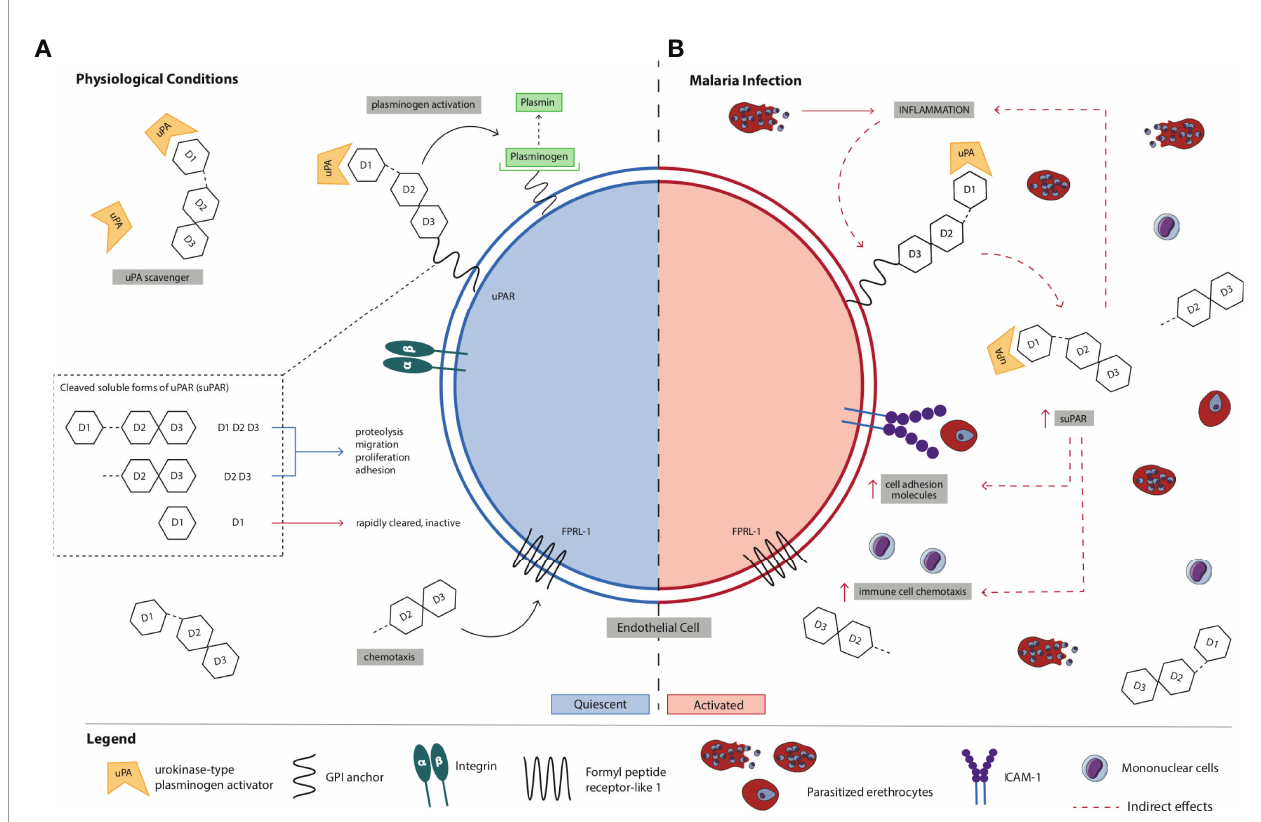
FIGURE 1 | Schematic representation of the (A) normal physiological role of suPAR in in fl ammation and immune activation vs. (B) proposed mechanism of action of suPAR in the pathogenesis of severe malaria. (A) uPAR is a three-domain (D1, D2, and D3) GPI-anchored protein expressed on the cell surface of immune, endothelial, epithelial, and smooth muscle cells. Full-length suPAR is involved in a variety of cellular processes including proteolysis, migration, proliferation, and adhesion through its interactions with ECM proteins such as integrins and vitronectins as well as other receptors. Also, suPAR is a regulator of the plasminogen activation system since it can scavenge and bind the serine protease uPA in the ECM thereby competitively inhibiting uPAR. Cleaved suPAR interacts with FPRL-1 to induce chemotaxis of immune cells (e.g., monocytes, neutrophils). suPAR D1 is rapidly cleared from circulation and is biologically inactive. suPAR is released into circulation during infection, and therefore, the circulating concentrations of suPAR re fl ect the extent of immune activation and in fl ammation in an individual. Under normal physiological conditions, low levels of circulating suPAR are detected in the healthy population. (B) During P. falciparum infection, PEs bind to and sequester in microvascular endothelial cells. Recognition and binding of parasite products (e.g., PfGPI) to Toll-like receptors on monocytes and ECs activates them to produce and secrete pro-in fl ammatory cytokines (e.g., TNF- a ) and chemokines, and there is upregulation of the expression of cell-adhesion molecules on endothelial cells (e.g., ICAM-1) to which PEs bind. Increased production of pro-in fl ammatory cytokines/chemokines and immune activation stimulate uPAR-expressing cells (e.g., monocytes) to produce and secrete suPAR. Initially, increased local levels of suPAR in children with malaria may promote protective innate immune responses in the host defense by promoting the recruitment of immune cells (e.g., neutrophils and monocytes) to acute sites of infection via its chemotactic effector functions. Through its interactions with other ECM proteins and receptors (e.g., integrins), suPAR can also trigger downstream signaling resulting in the upregulation and expression of adhesion molecules (e.g., ICAM-1). In the absence of early treatment, parasite numbers continue to increase and PEs further accumulate and sequester in microvascular ECs due to the upregulated expression of adhesion molecules. As a result, the production and secretion of pro-in fl ammatory cytokines/chemokines are exacerbated, ultimately resulting in a systemic increase in in fl ammation and immune activation. Elevated circulating suPAR may amplify the release of cytokines/chemokines and the recruitment of immune cells, which contributes to sustained systemic in fl ammation and immune activation. Excessive in fl ammation in malaria could also trigger biological processes leading to marked increases in circulating suPAR. Although further studies are needed to elucidate its role, suPAR may contribute to enhanced chemokine and cytokine secretion that culminates in endothelial dysfunction, multiorgan failure, and death in children with malaria. High circulating concentrations of suPAR in children with malaria may therefore re fl ect excessive activation of immune cells, adhesion of PEs at sites of in fl ammation, disturbances in hemostasis, or a combination of these. Collectively, suPAR may be involved in a positive feedback loop that results in high levels of local and systemic immune activation and in fl ammation through its own pro-in fl ammatory properties and by activating and recruiting other chemokines and cytokines via chemotaxis. Also, the pathobiology of severe falciparum malaria is associated with upregulation of coagulation pathways. Elevated suPAR levels may indirectly exert pro-coagulant effects by enhanced binding to uPA and competitive inhibition of membrane-bound uPAR thereby indirectly inhibiting uPA-dependent fi brinolysis or by stimulating activation of coagulation mechanisms via intrinsic and extrinsic pathways. Elevated levels of suPAR in children with malaria may re fl ect the degree to which some or all of these processes occur. EC, endothelial cell; ECM, extracellular matrix; P. falciparum , Plasmodium falciparum ; PfGPI, GPI, Plasmodium falciparum glycosylphosphatidylinositol; GPI, glycosylphosphatidylinositol; ICAM-1, intercellular adhesion molecule-1; PE, parasitized erythrocyte; SM, severe malaria; suPAR, soluble urokinase-type plasminogen activator receptor; uPA, urokinase or urokinase-type plasminogen activator; uPAR, urokinase-type plasminogen activator